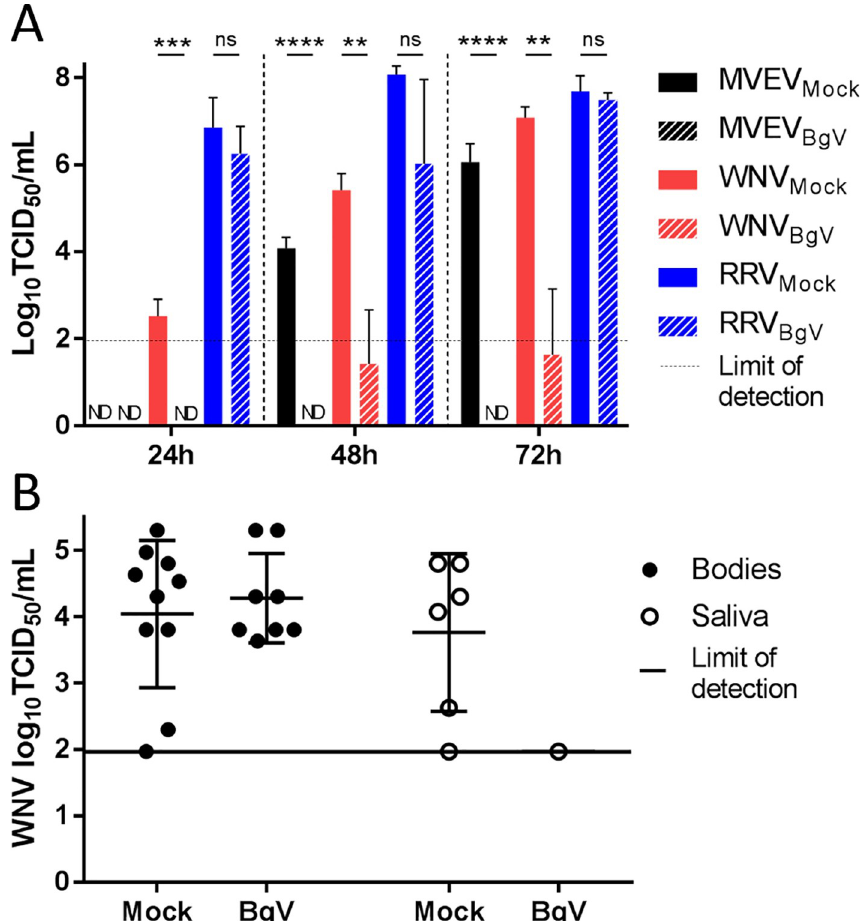
prevent further interference from BgV. ND = not detected. Error bars stand for the standard deviation. The results were analysed with a parametric unpaired t-test. ns = not significant (P > 0.05), �� = P < 0.01, ��� = P < 0.001, ���� = P < 0.0001. (B) WNV titres in the bodies and saliva of Culex mosquitoes mock- or BgV-injected, and subsequently exposed to WNV in an infectious blood-meal. Error bars represent the standard deviation and middle bars represent the